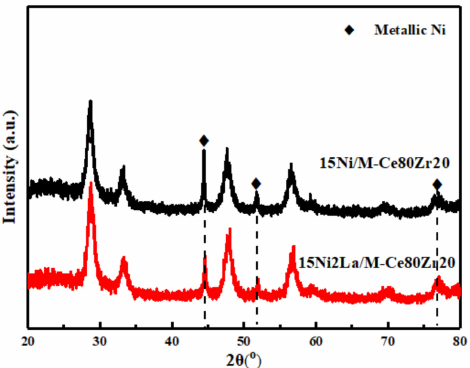
Figure 11. XRD patterns of the spent 15Ni/M-Ce80Zr20 and 15Ni2La/M-Ce80Zr20 catalysts after 40 h long-term stability